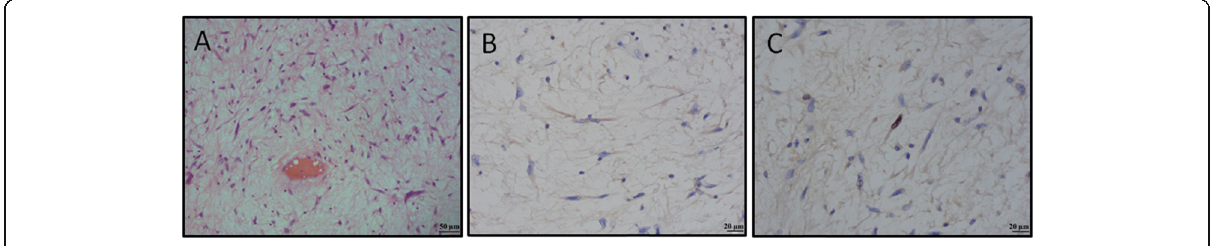
Fig. 1 Microscopic (histologic) images of a low-grade fibromyxosarcoma. a ) hypocellular neoplasm is composed of atypical fibroblasts and pseudo-lipoblasts embedded in a prominent myxoid matrix (H&E staining, 200x magnification), b ) tumor cells stain positive for epithelial membrane antigen (EMA staining, 400x magnification), and c ) proliferative activity in tumor cells is low (Ki-67 staining, 400x